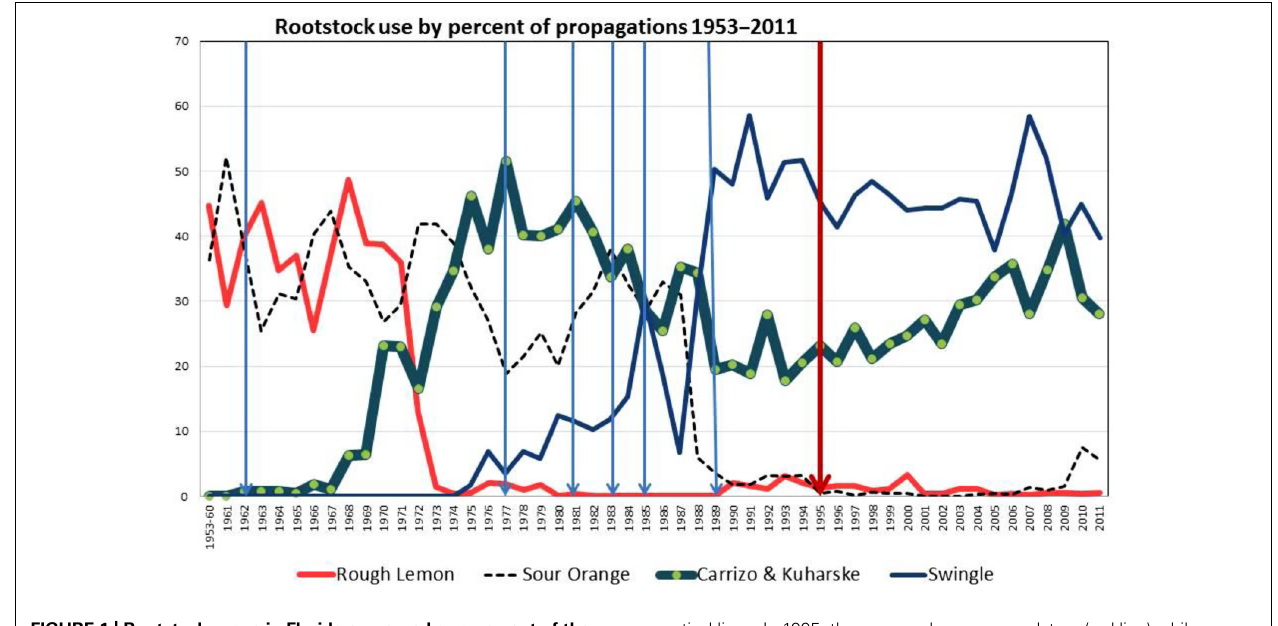
FIGURE 1 | Rootstock usage in Florida expressed as a percent of the total propagations since the beginning of the Florida Budwood Regis- tration Bureau in 1953. Major freeze occurrences are indicated by blue